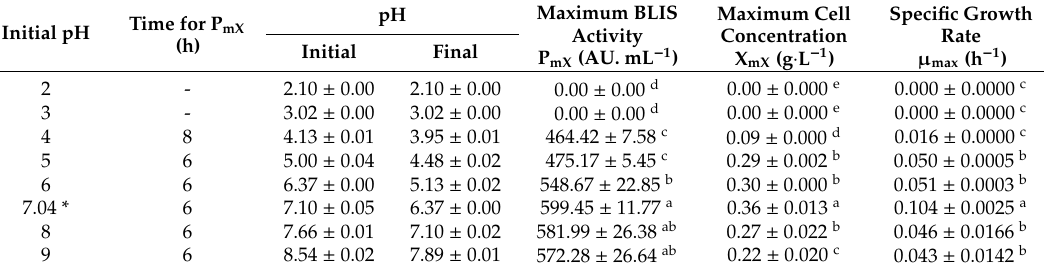
Figure 1. Growth profile of L. lactis Gh1 in Brain heart infusion (BHI) broth. Table 3. E ff ects of initial culture pH on growth of L. lactis Gh1 and BLIS production using BHI medium.